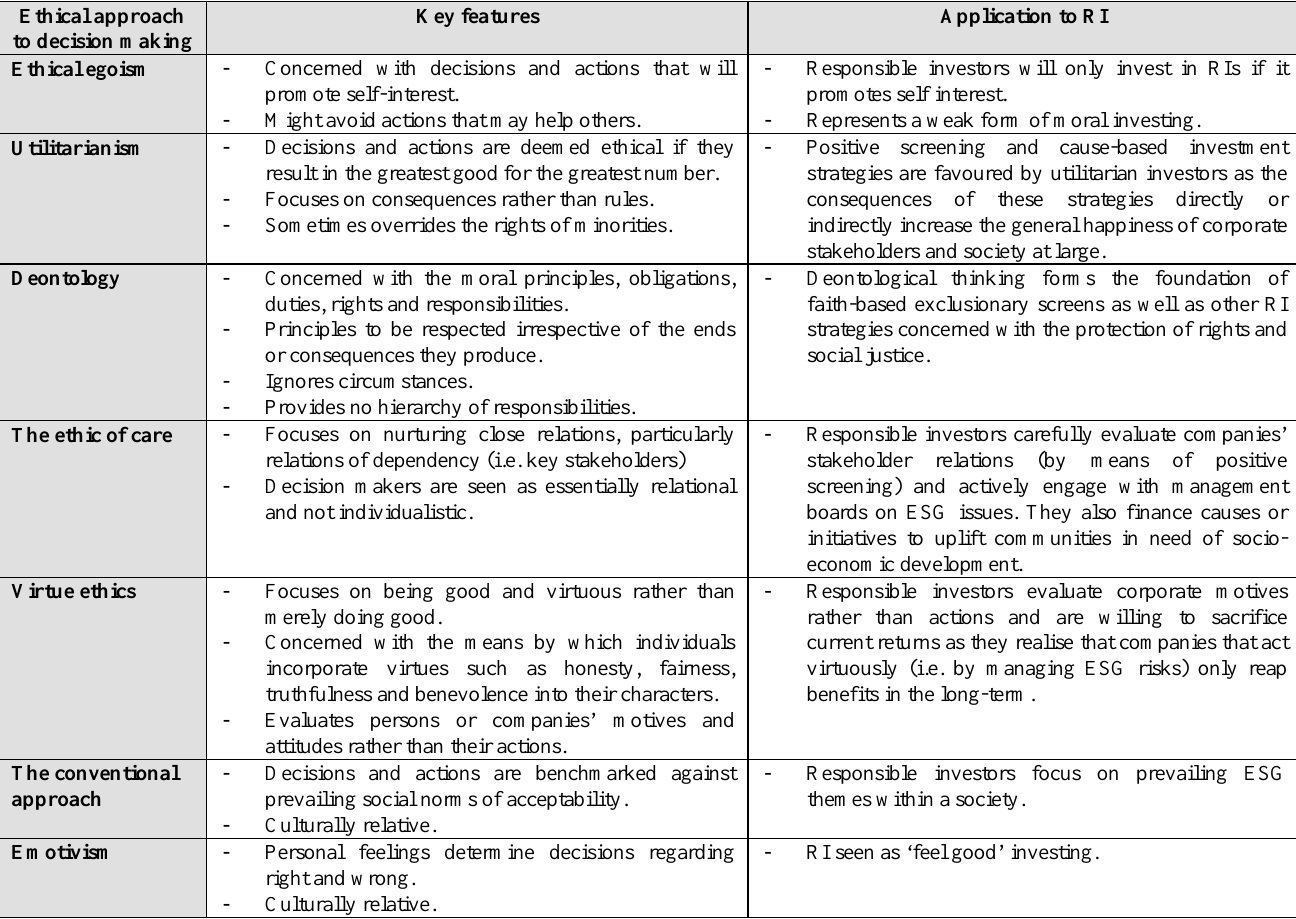
Table 2: Summary of ethical approaches to ethical decision making and their application to